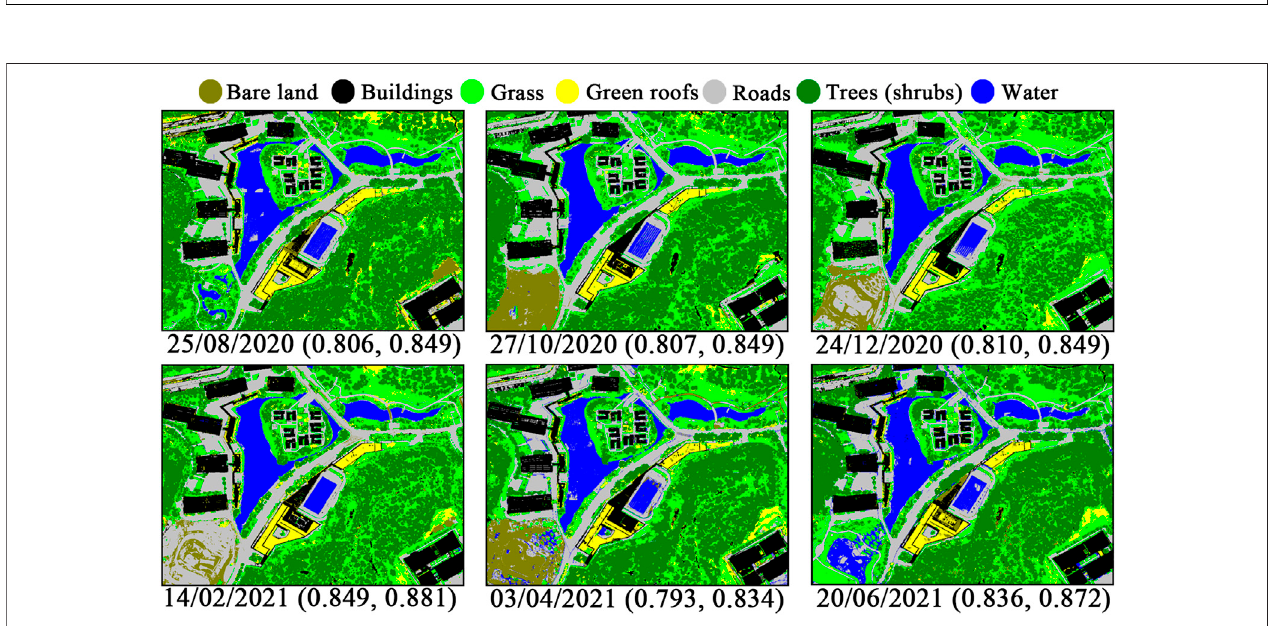
FIGURE7| Results onasunnyday (left)and an overcastday (right), and thekappa coef fi cients and OAs. Thered circles indicate themain differences between the two sub fi gures.